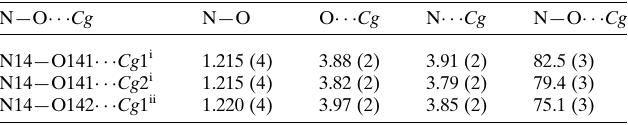
Table 2 Parameters (A˚ , (cid:3) ) for nitro (cid:2)(cid:2)(cid:2) (cid:2) (arene) interactions. Cg 1 and Cg 2 are the centroids of the C1 A –C6 A and C1 B –C6 B rings, respectively. N—O (cid:2)(cid:2)(cid:2) Cg